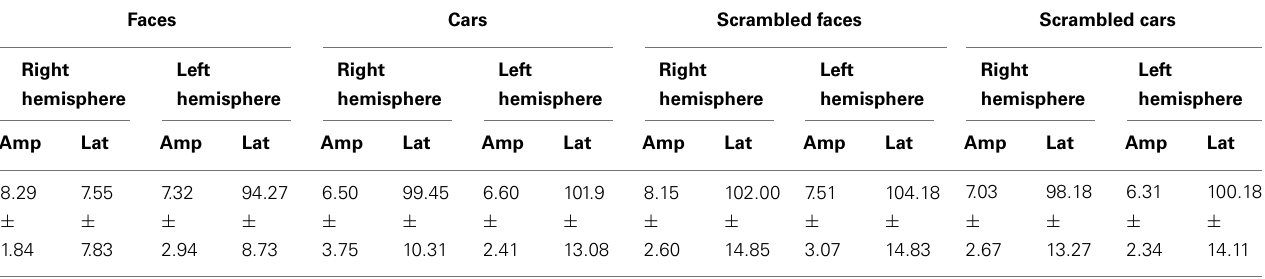
Table 1 | Mean amplitude and latency values of P1 component for younger